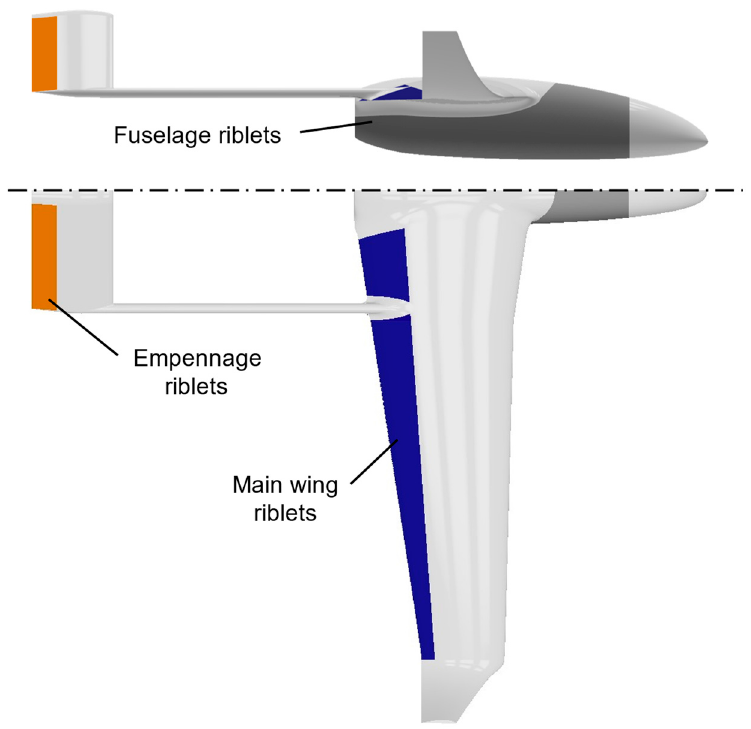
Figure 10. Areas of riblet application. Table 3. Boundary layer transition points to fully turbulent for the examined planes of the